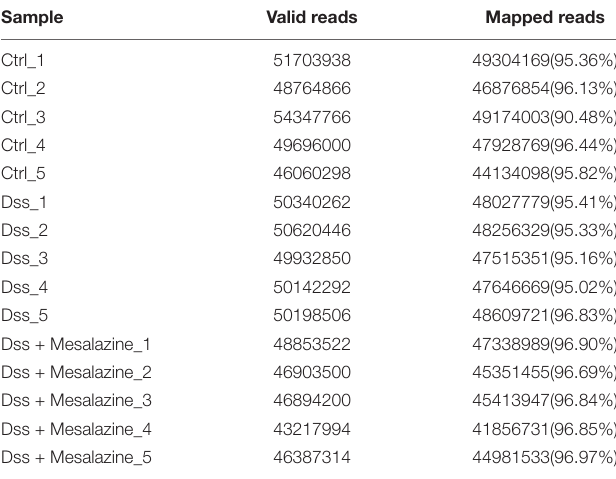
TABLE 6 | Reversed effects of Mesalazine on the DSS-altered